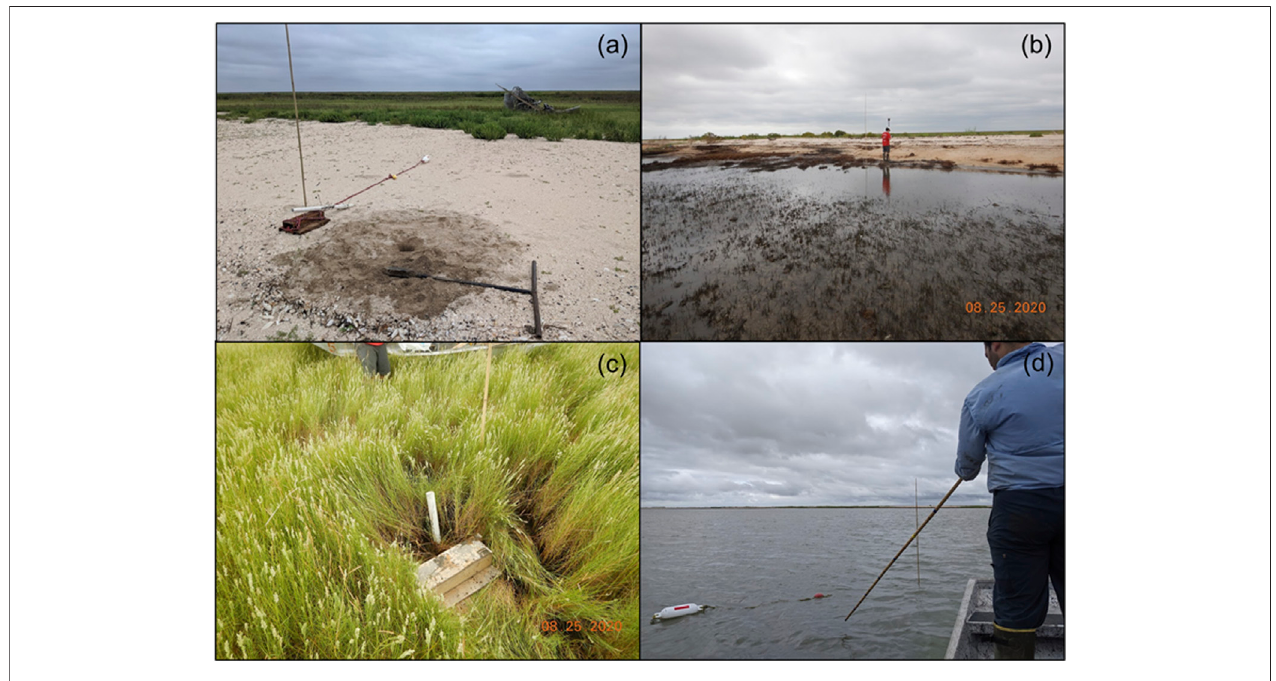
FIGURE 3 | Placing wave gauge and burying piezometers along beach shoreline (A) , conducting GPS-RTK measurements from the shoreline-inland (B) , typical study site layout with wave gauge, cane-pole marker, and PVC pipe attached to buried piezometers (C) , and deploying wave gauge offshore (D) .